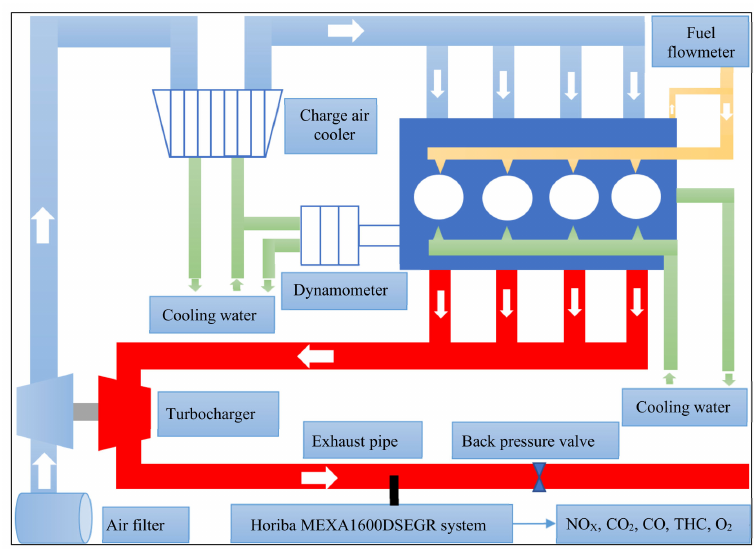
Figure 1. Schematic diagram of diesel engine bench emission